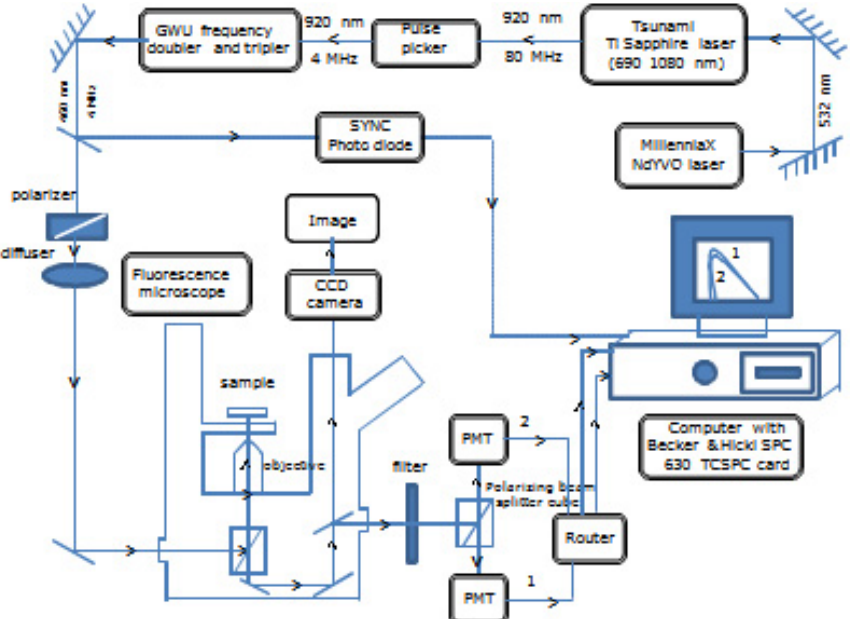
Fig. 3. Schematic diagram of the °uorescence microscope setup used for acquiring time-resolved epi-phosphorescence data on live cells. The main components are (i) a picosecond laser (ii) an inverted °uorescence microscope (iii) a TCSPC